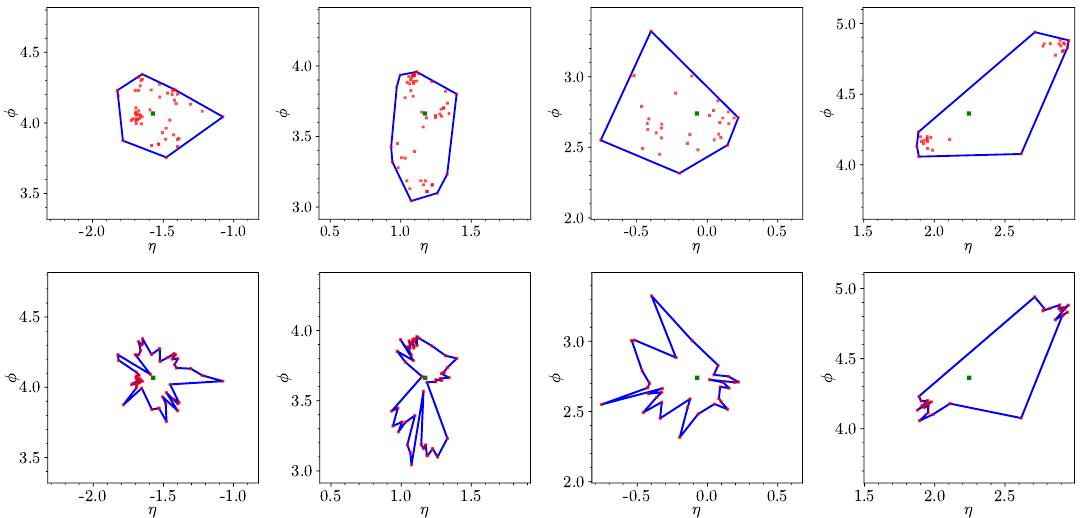
Figure 2. Top panels: convex hull masks. Bottom panels: radial masks. Green dots represent y × φ coordinates of Higgs bosons, while red dots represent η × φ coordinates of their decay products.